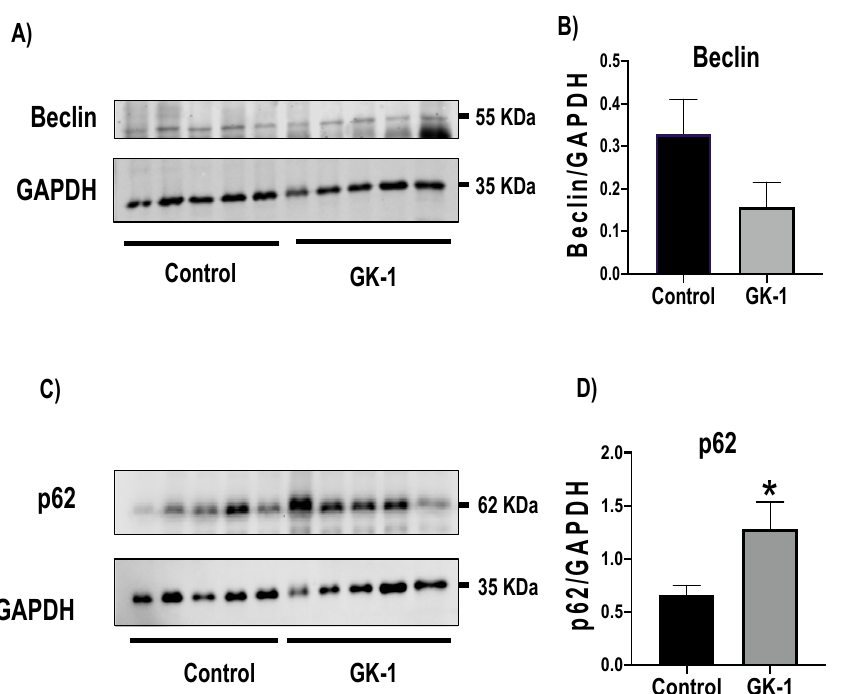
Figure 9. GK-1 disrupts autophagy flux. ( A , C ) Immunoblots and ( B , D ) densitometric analyses of Beclin and p62, respectively, in tumors treated with GK-1 and saline solution (control). Glyceraldehyde 3-phosphate dehydrogenase (GAPDH) was used as the loading control. t -Student test, control vs. GK-1, * p < 0.05. Data are expressed as mean ± SEM, n = 5.